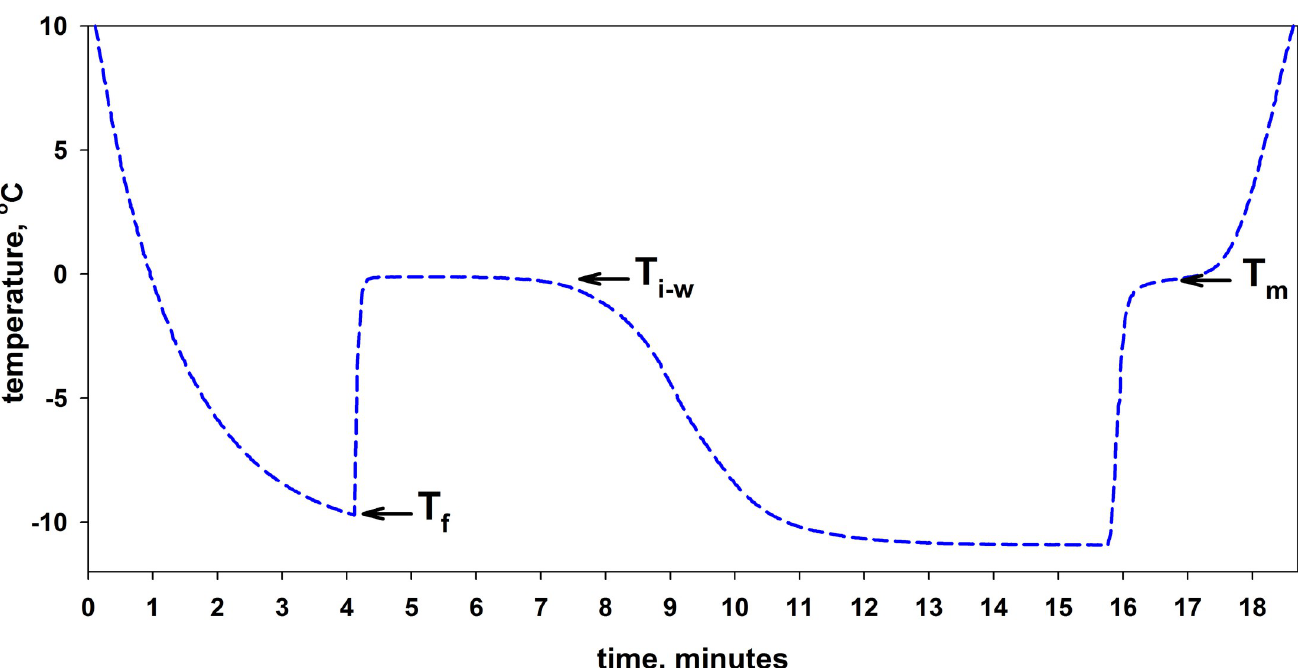
Fig 1. Time dependence of the sample temperature during cooling and subsequent heating. A room-temperature sample (buffer, 20mM Tris-HCl, pH 7.5) was kept in a thermostat at -11˚C for the time interval from zero to the 15th minute and after that transferred to a thermostat pre-heated to +25˚C for further monitoring from the 15th minute onwards. The arrows show the curve stretches where the freezing point of water T f , the temperature of coexistence of ice and water T i-w , and the melting point of ice T m were determined. For details of temperature determination, see Materials and